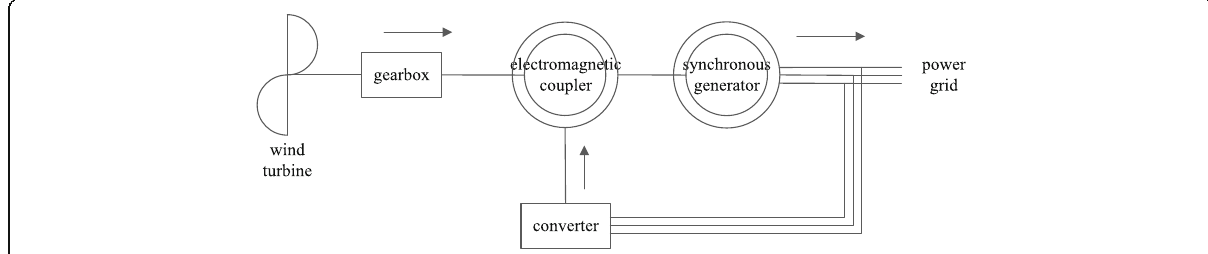
Fig. 2 Electromagnetic coupling speed-regulating wind turbine structure diagram